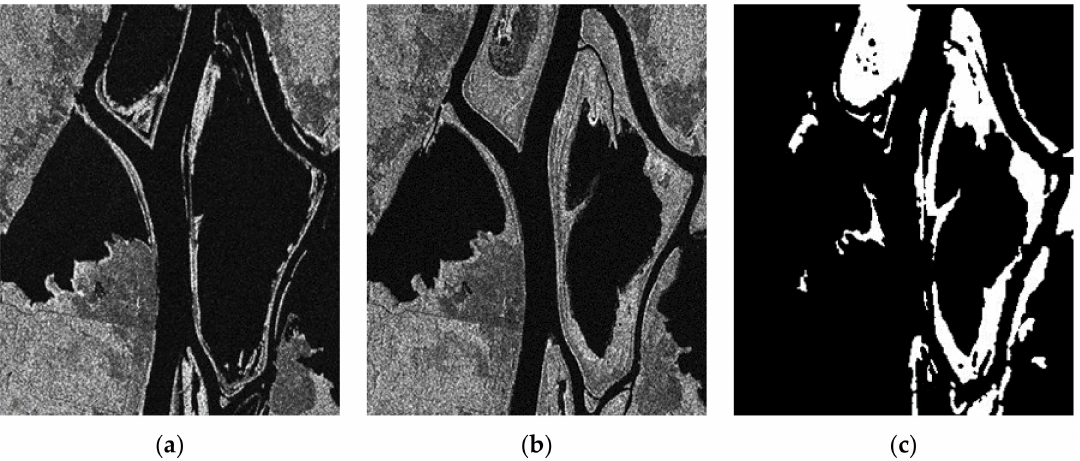
Figure 6. Ottawa dataset. ( a ) Image acquired in July 1997. ( b ) Image acquired in August 1997. ( c ) Ground truth.